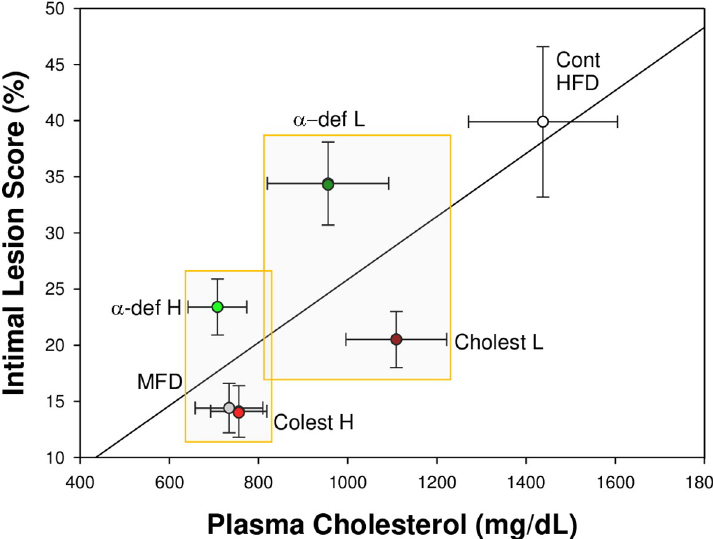
Fig 2. Correlation between plasma cholesterol and size of lipid-rich streaks in aortic roots. Data from the six groups of ApoE − / − mice described in Fig 1, panels A and B are compared (regression line), and separately for each experimental group (mean ± SD, n = 16 per group). A highly significant correlation is noted in between plasma cholesterol and lesion size, plotted for the entire cohort of mice (R = 0.7, p < 0.0001, Pearson’s correlation). The two rectangles illustrate experimental groups with comparable plasma cholesterol but significantly higher lesion size score in the α -def-1 groups (p < 0.001, ANOVA).